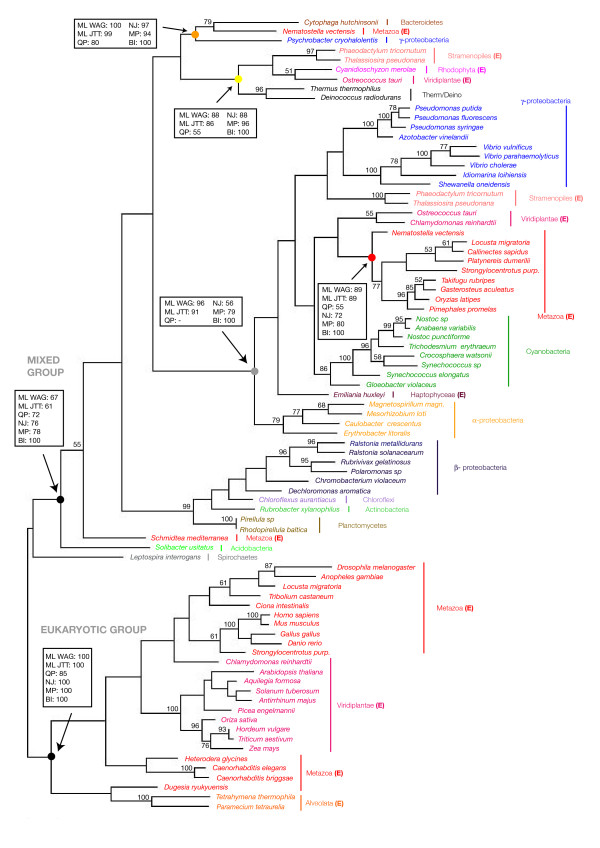
Phylogenetic tree of the class 4 HDACs. The represented tree is a maximum-likelihood (ML) tree produced with PHYML (using the WAG model of protein evolution). Rooting is arbitrary. Numbers above the internal branches are their bootstrap support values (100 bootstrap replicates). Only bootstrap support values >50% are shown. Other internal branches (with bootstrap support <50%) should be considered unreliable. In addition to the values shown for the other statistically supported internal branches (ML WAG), some key internal branches are labelled with additional statistical support values obtained by other methods of phylogenetic reconstruction or other models of evolution: bootstrap support in PHYML analysis with the JTT model of evolution (ML JTT; 100 bootstrap replicates), ML quartet puzzling support (QP; 25,000 puzzling steps), bootstrap support in neighbour-joining (NJ) analysis (BioNJ algorithm, 10,000 bootstrap replicates), bootstrap support in maximum-parsimony (MP) analysis (heuristic search; 500 bootstrap replicates), and posterior probabilities (Bayesian inference, BI). More details on the phylogenetic analyses can be found in the Methodssection and additional trees can be found in Additional Files 3, 4, 5. Eukaryotic lineages are marked by a bold "E". Colored circles highlight internal nodes defining monophyletic groups discussed in the main text. Black circles define two large groups: the "eukaryotic group" including proteins of species belonging to three of the main eukaryotic lineages, namely the opisthokonta (metazoa), plantae (viridiplantae), and chromalveolata (alveolata), and the "mixed group" comprising proteins of species belonging to various eubacterial and eukaryotic lineages. The grey circle denotes, inside the mixed group, a monophyletic group containing both eukaryotic and eubacterial sequences. The red circle indicates a monophyletic group comprising class 4 HDACs of nine animals; these HDACs show closer resemblance to eubacterial proteins than to those of other animals. The yellow circle defines a group comprising four HDACs of distantly related eukaryotic planctonic species. The orange circle denotes a group comprising an HDAC sequence of the cnidarian Nematostella vectensis and those of two unrelated eubacteria. The multiple alignment on which this tree is based is available as Additional File 8.